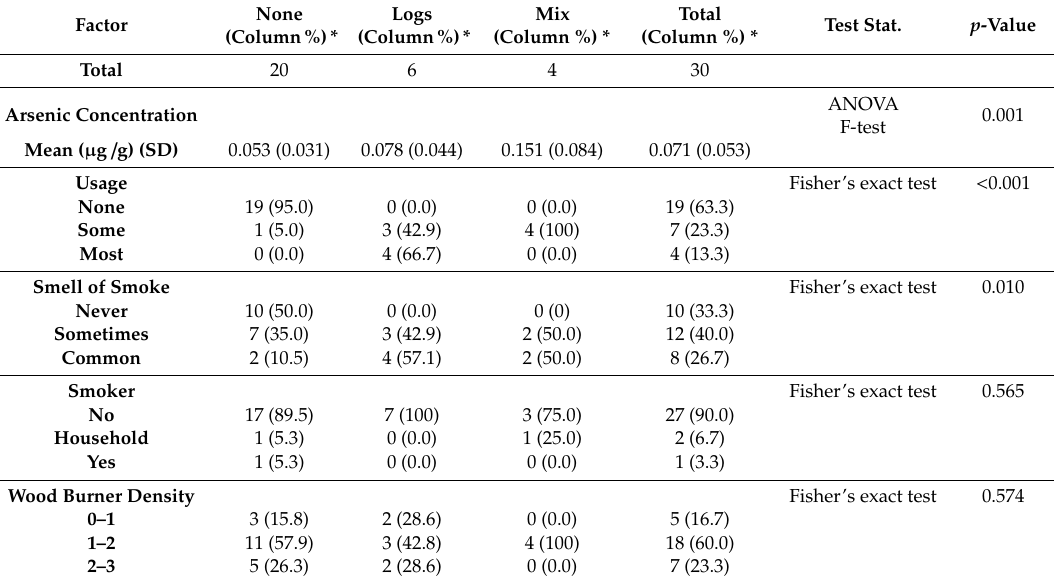
Table 1. Arsenic concentrations of beard hair and other characteristics of subjects by fuel type used. None Factor